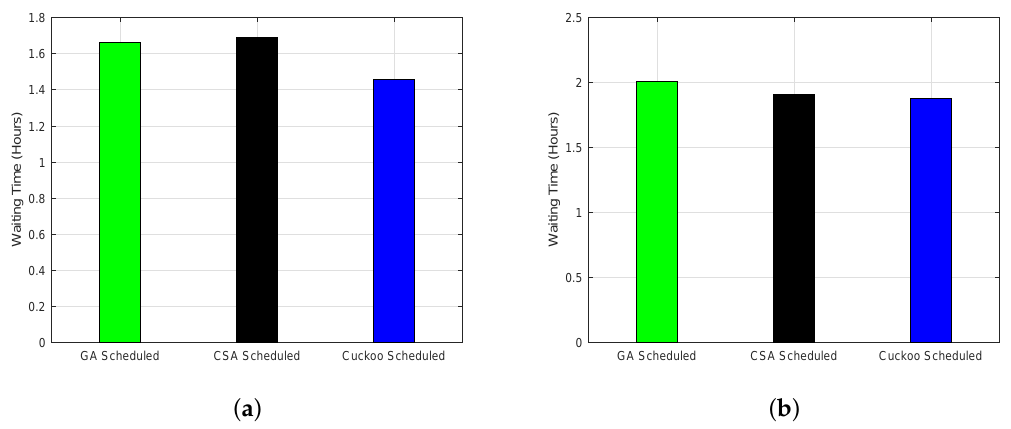
Figure 15. Appliances’ waiting time. ( a ) Waiting time for a single smart home; ( b ) waiting time for 30 smart